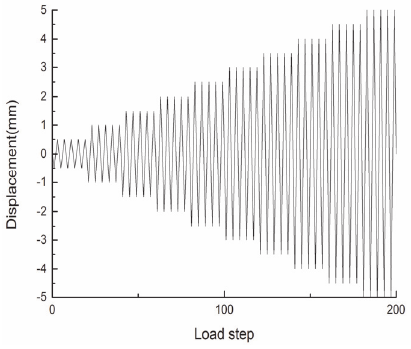
Figure 3: Displacement load curve. Figure 4: Signal collection